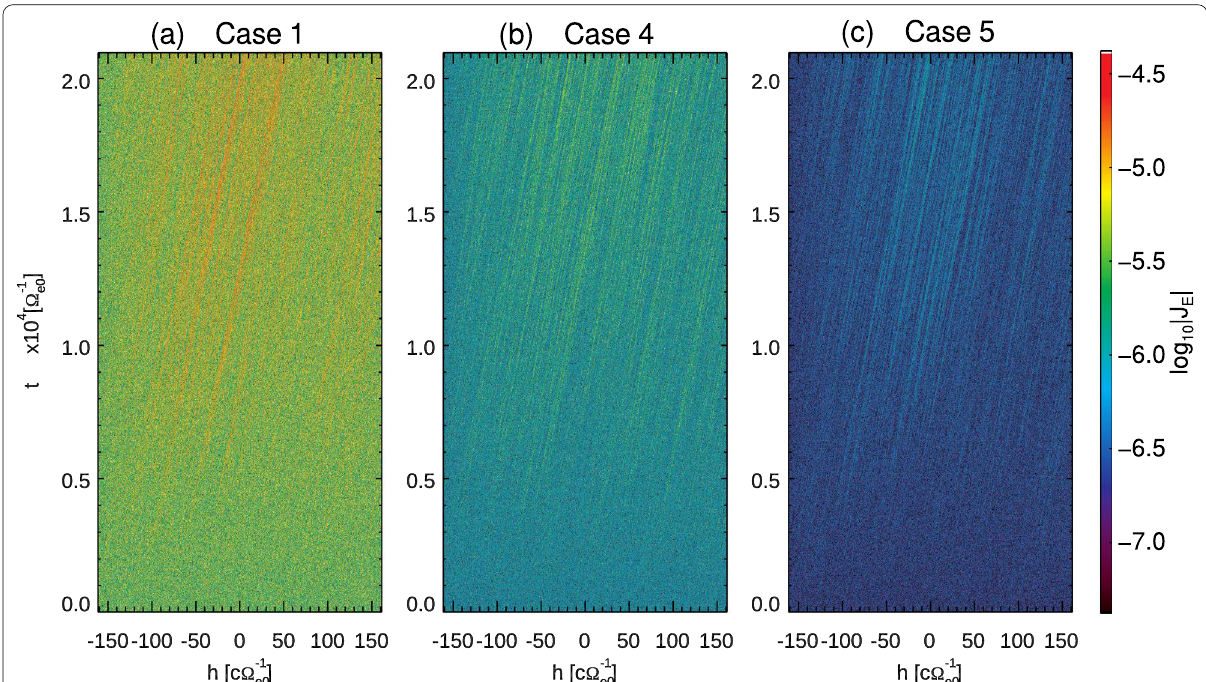
Fig. 12 Spatial and temporal evolution of J E for forward-propagating waves within the time period of t = 0 ∼ 2.04 × 10 4 [ (cid:31) − 1 e 0 ] in Case 1, Case 4, and Case